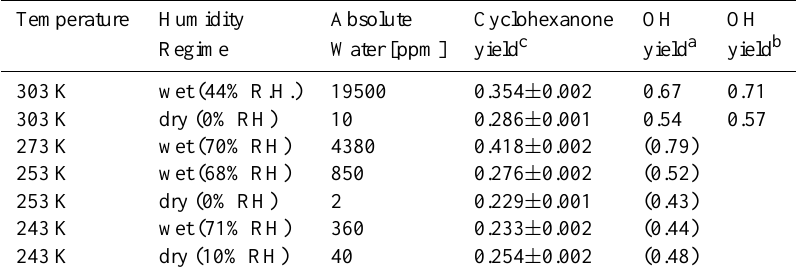
Table 2. Cyclohexanone and OH yields. Temperature Humidity Absolute